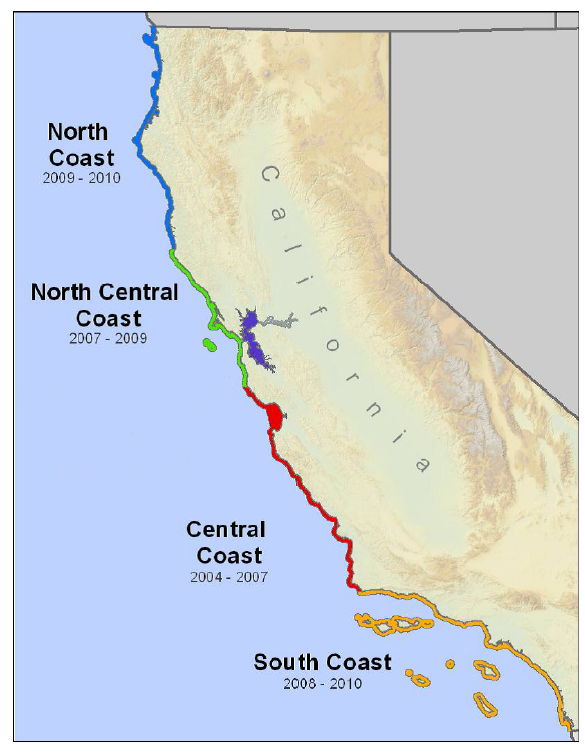
Fig. 1 . The four consecutive study regions where planning